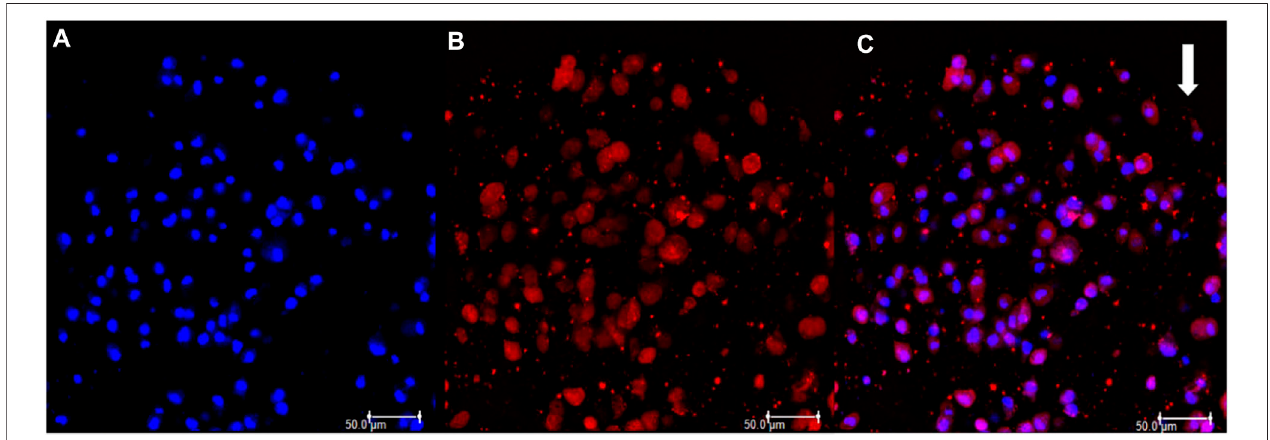
FIGURE 6 | (A) DAPI positive labelling showing cell nuclei stained in blue. (B) Qtracker positive labeling showing cell cytoplasm stained in red. (C) Labellings merged. White arrow indicates the border of the capsule.